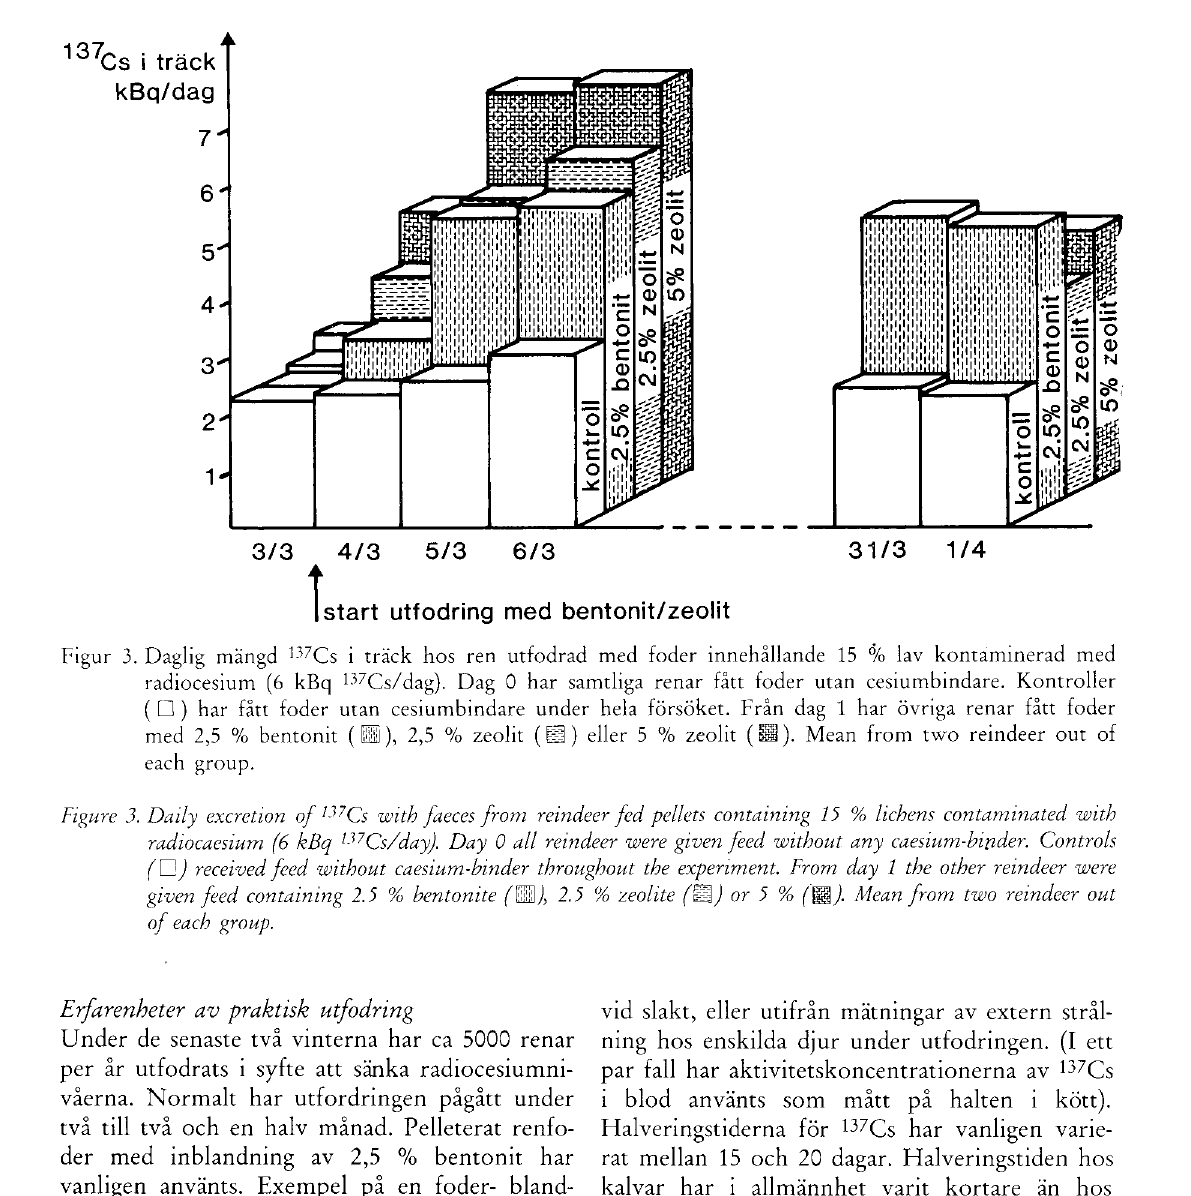
Figure 3. Daily excretion of 137 Cs with faeces from reindeer fed pellets containing 15 % lichens contaminated with radiocaesium (6 kBq L37 Cs/day). Day 0 all reindeer were given feed without any caesium-hinder. Controls (^]) received feed without caesium-hinder throughout the experiment. From day 1 the other reindeer were given feed containing 2.5 % bentonite (M) 2.5 % zeolite (M) or 5 % (M)- Mean from two reindeer out 3 of each